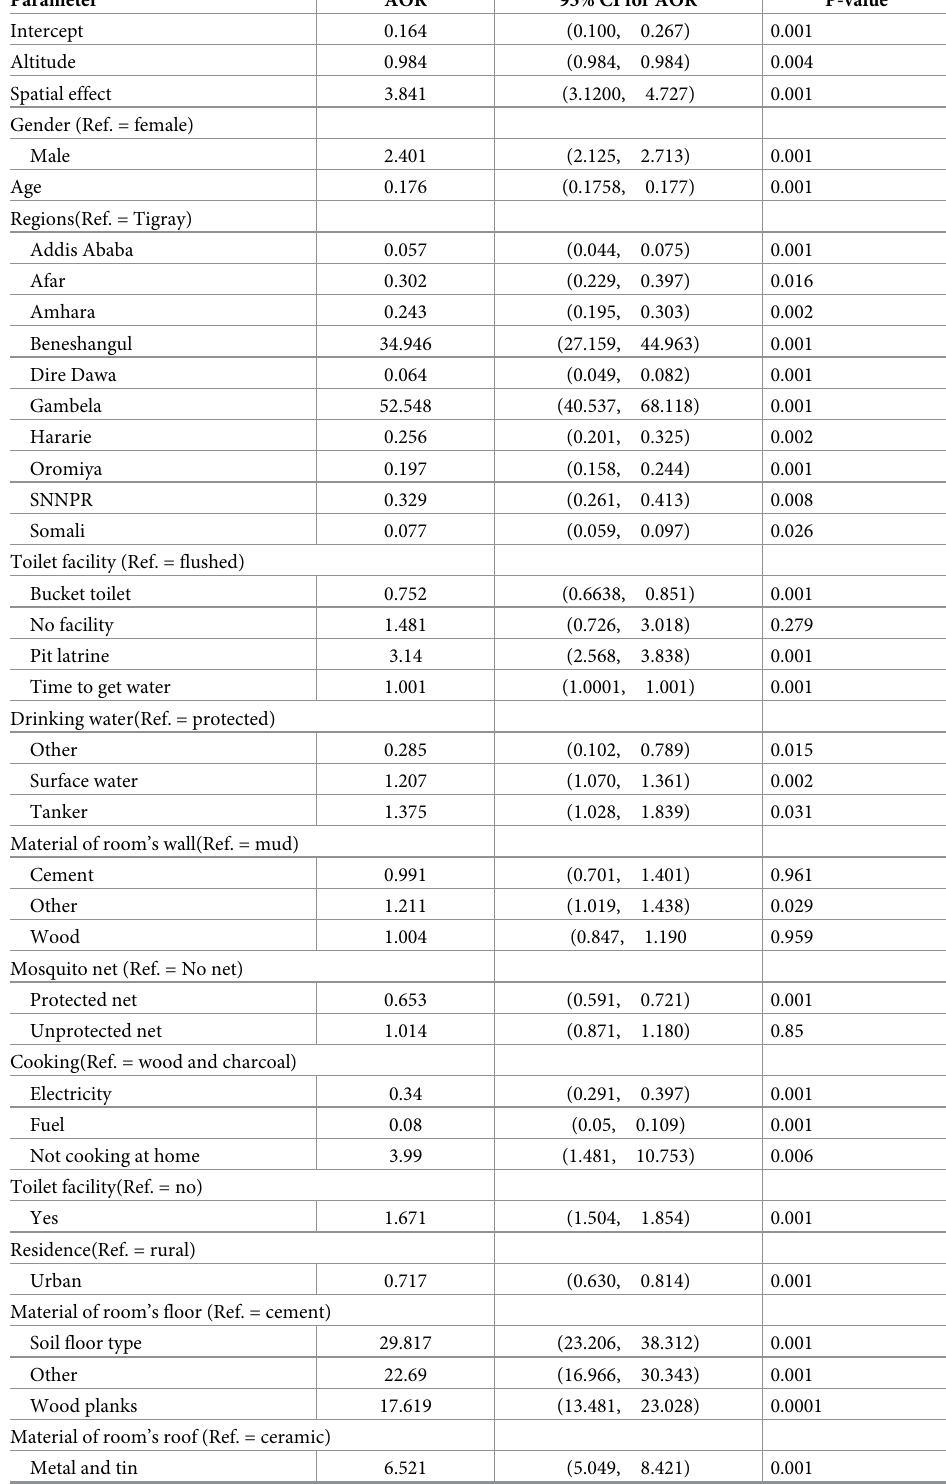
Table 2. Parameter estimates for auto logistics regression